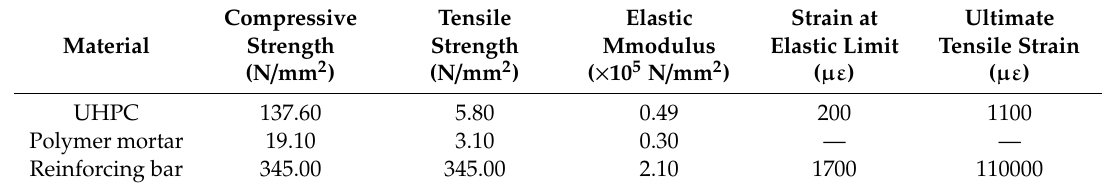
Table 1. Mechanical properties of the strengthening materials. UPHC: ultra-high performance concrete. Tensile Compressive Material Strength